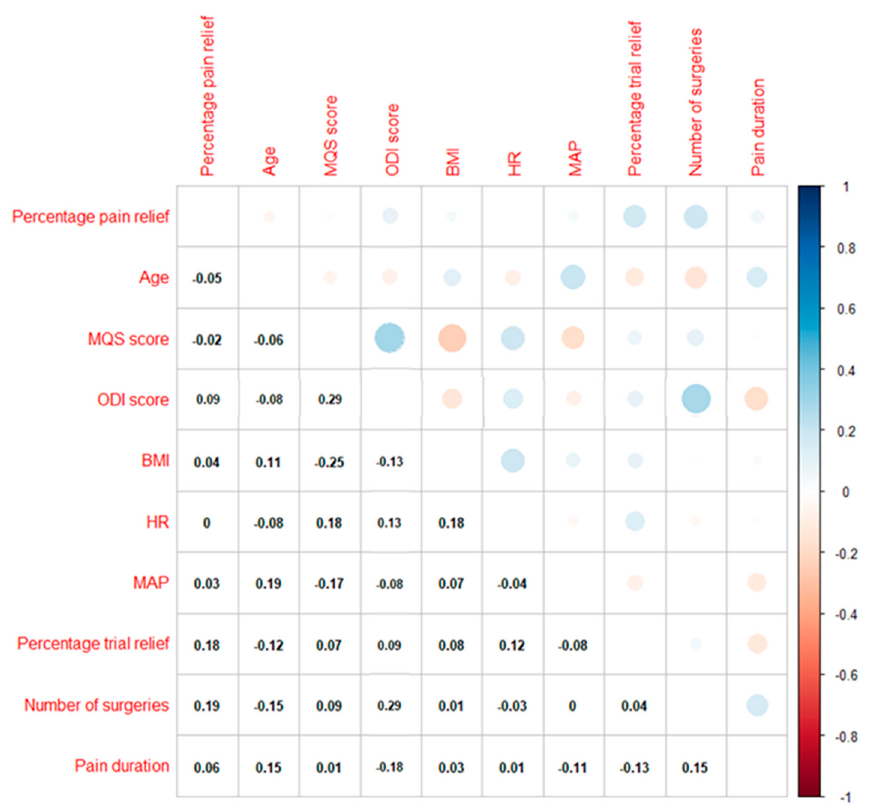
Figure 3. Correlation plot between percentage pain relief and explanatory variables for the training data set. Correlation coefficients are ranging from − 1 (red) to +1 (blue). The strength of the correlation is represented in the size of the circles. Abbreviations. BMI: body mass index, HR: heart rate, MAP: mean arterial pressure, MQS: Medication Quantification Scale III, ODI: Oswestry Disability Index.